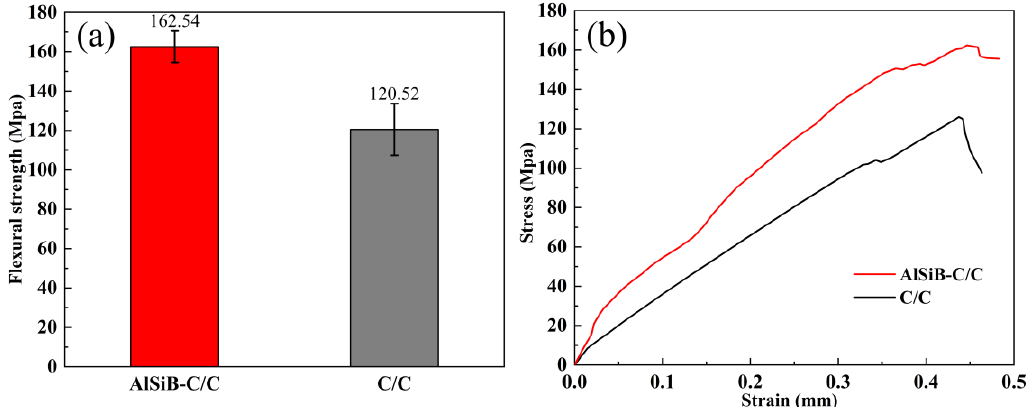
Figure 4. ( a ) Flexural strength and ( b ) the stress – strain curve of AlSiB-C/C and C/C.